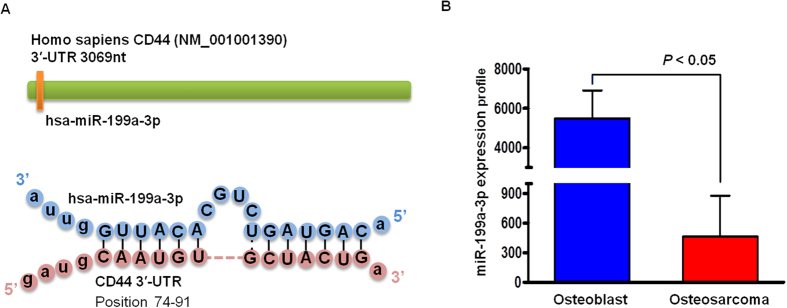
CD44 is a direct target of miR-199a-3p, and the miR-199a-3p expression profile in osteoblast and osteosarcoma cell lines.A Alignment of the predicted miR-199a-3p 3′-UTR target sequences of CD44 mRNA. The seed match sequences for miR-199a-3p are indicated by lines. B comparison of miR-199a-3p expression levels between in comparison with osteoblasts (HOB-c and NHOst) and osteosarcoma cells (U-2OS and KHOS) based on the miR microarray platform and unsupervised hierarchical clustering analysis.